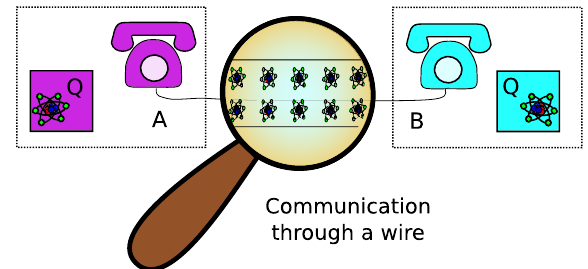
FIG. 1. Wires for classical communication are quantum